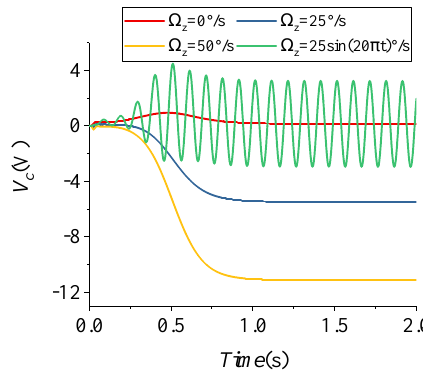
Figure 11. Coriolis path output curves.